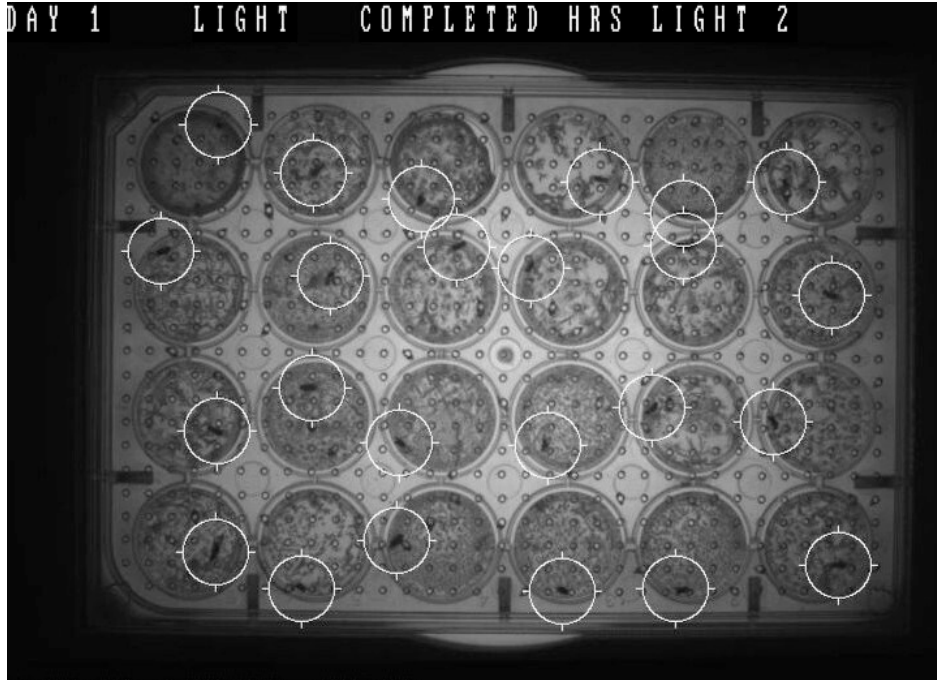
Figure 4. An example of the study of circadian rhythms in Drosophila using the software. (The image is from Protic’s lab: www.polyfrax.com, accessed on 1. December 2022.). A multi-well plate was